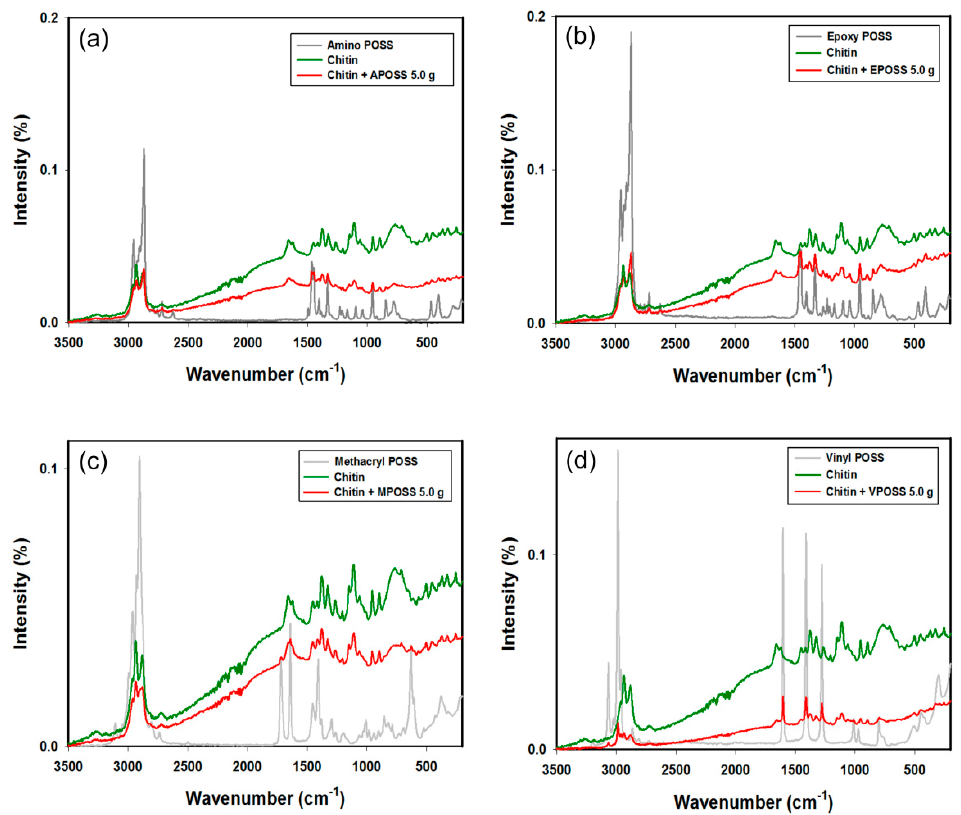
Figure 2. Raman spectra of α -chitin, POSS compounds and the resulting hybrid materials: ( a ) chitin-APOSS; ( b ) chitin-EPOSS; ( c ) chitin-MPOSS; and ( d ) chitin-VPOSS.